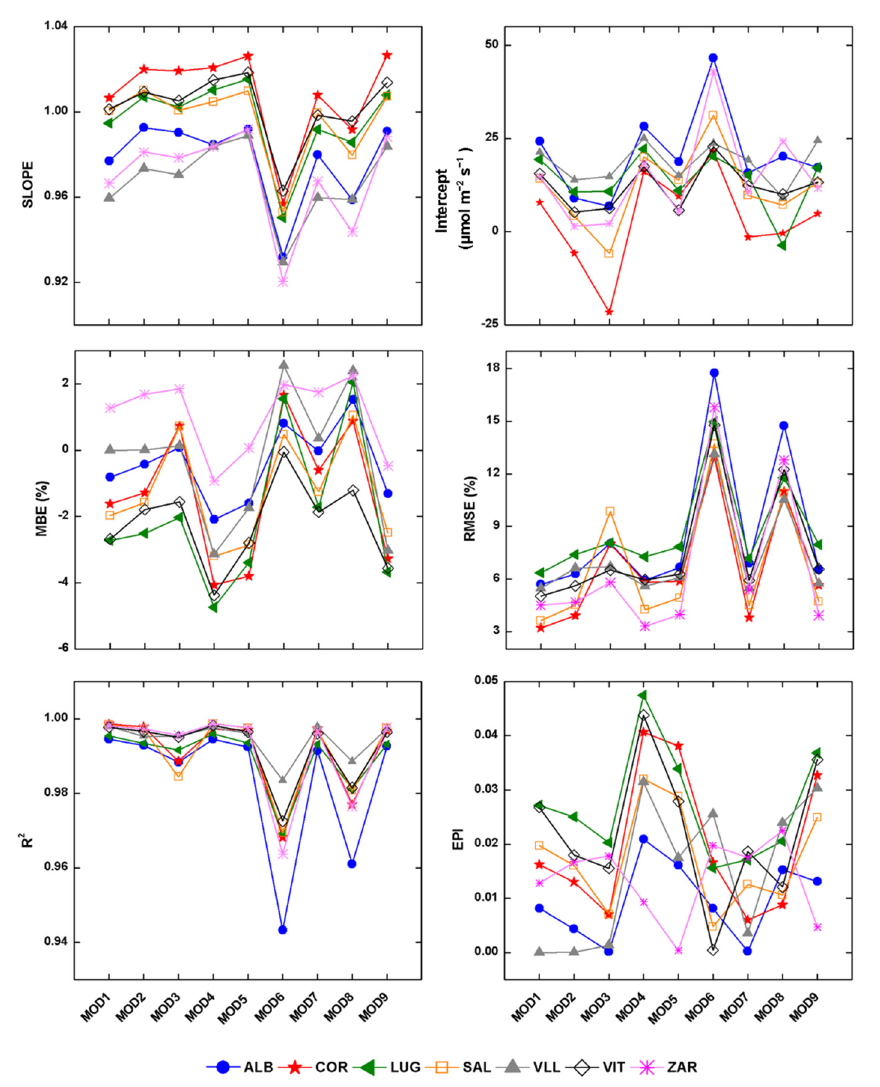
Figure 2. Statistical results of the nine ANN models for each